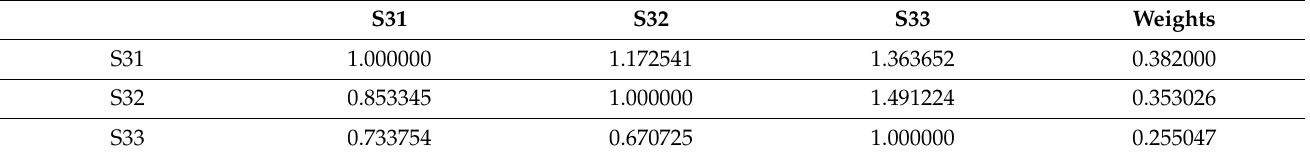
Table 9. The aggregated pairwise comparison matrix at Level 2 for